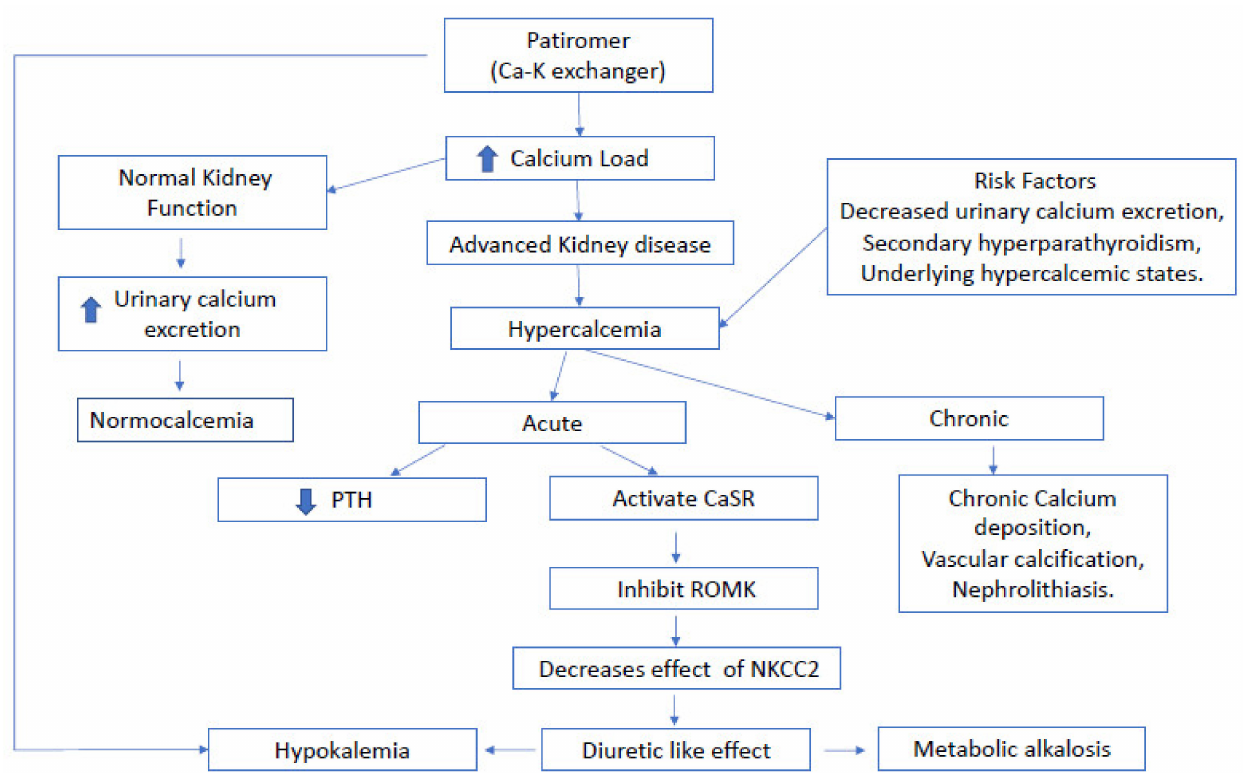
Figure 1. Schematic representation of proposed acute and chronic calcium homeostasis in patients on patiromer with advanced kidney disease. PTH: parathyroid hormone. ROMK: the renal outer medullary potassium channel. CaSR: the calcium sensing receptor. NKCC2: the sodium-potassium-2 chloride